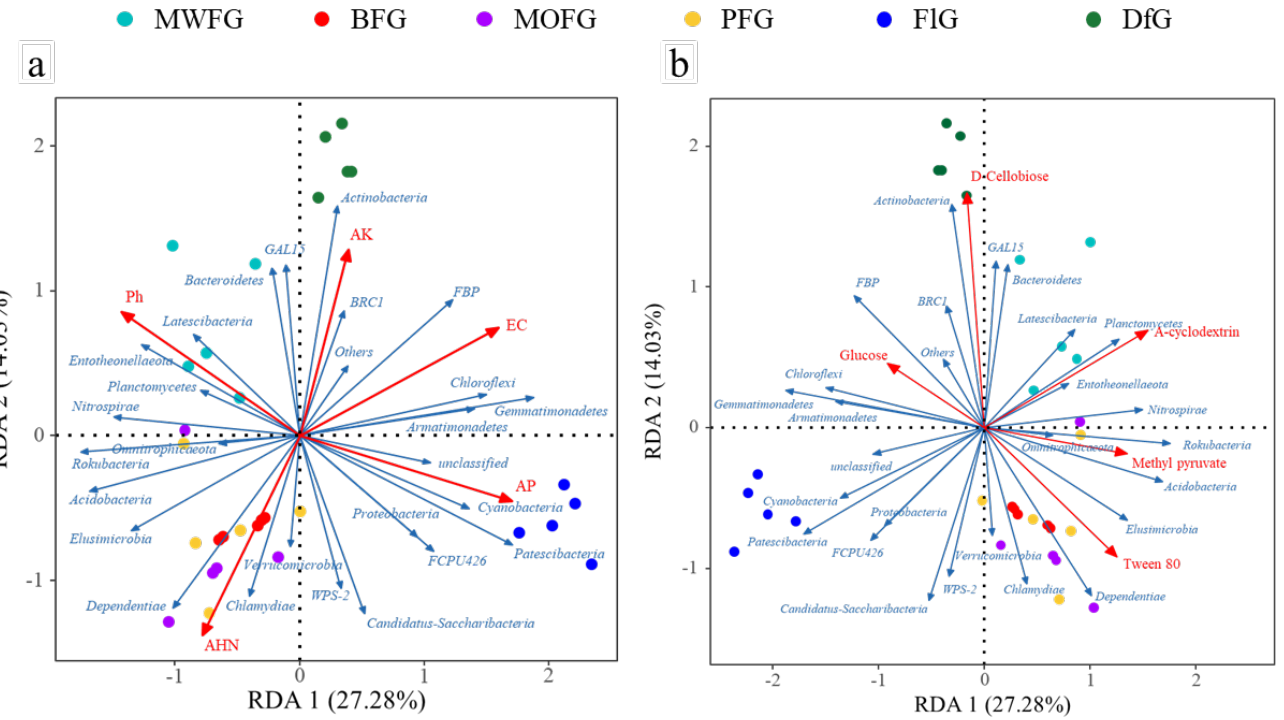
Figure 5. The RDA of bacteria and soil chemical properties ( a ). The single carbon source ( b ) at the gate level. Blue arrow: door of bacteria; red arrow: soil chemical properties ( a ), and the single carbon source ( b ). MOFG, Mongolian oak forest ginseng; BFG, birch forest ginseng; MWFG, miscellaneous wood forest ginseng; PFG, poplar forest ginseng. FlG, farmland ginseng; DfG, deforestation ginseng.